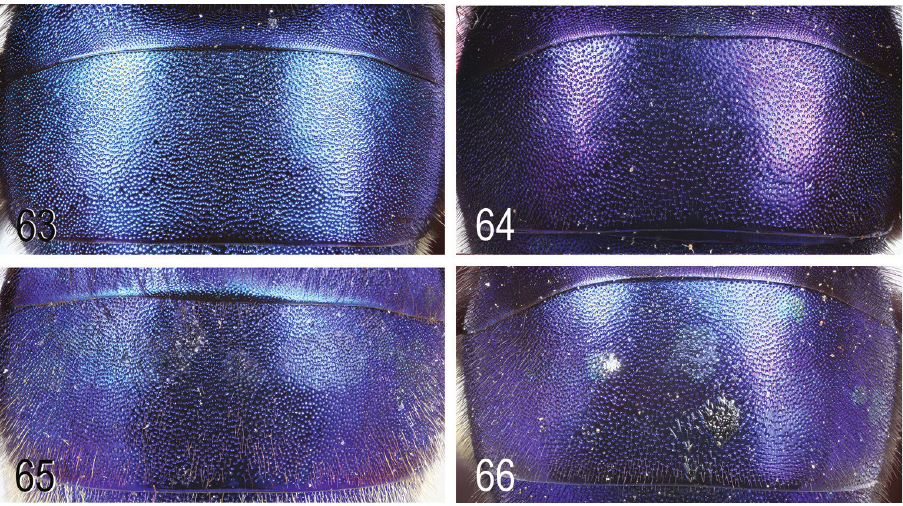
Figures 63–66. Female second metasomal tergum. 63 E. oliveri (paratype. Mexico: Guerrero, EMEC 1069136) 64 E. simillima (paratype. Mexico, Maguarichi, KUNHM-ENT 1091973) 65 E. barthelli (paratype. Mexico: Morelos, Tepoztlán, UNAM 01827) 66 E. micheneri (paratype. Mexico: Jalisco, Mas- cota, KUNHM-ENT